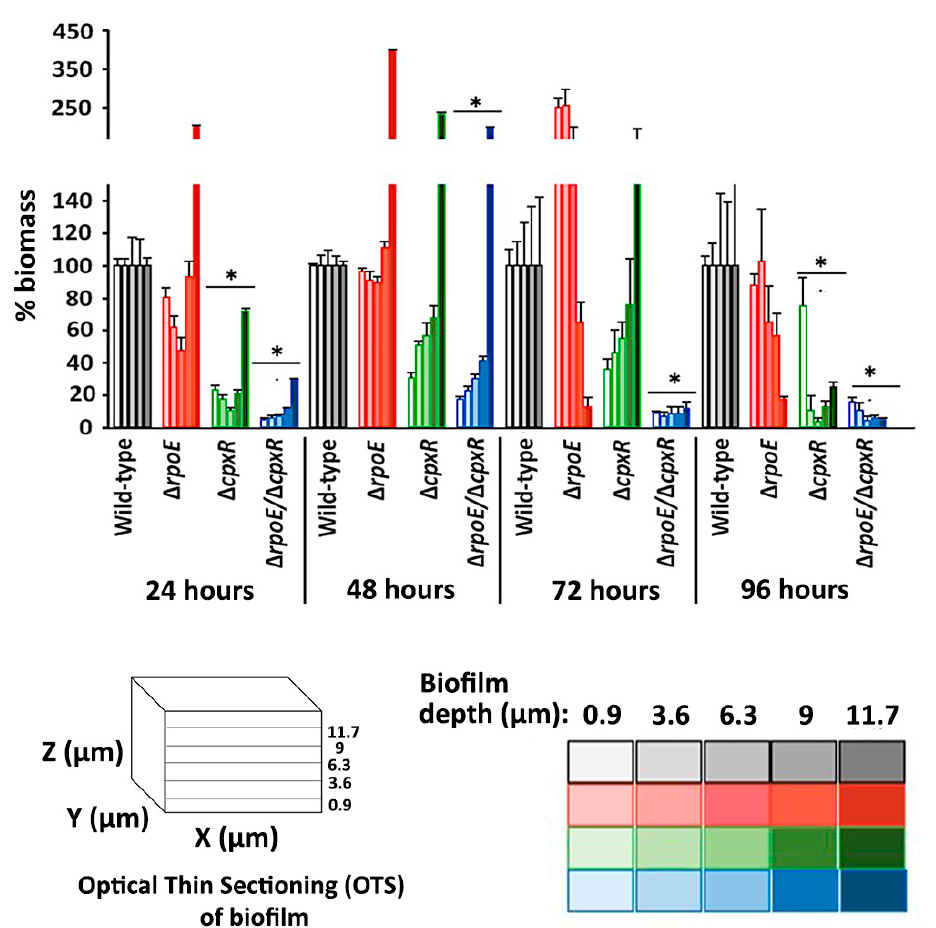
Figure 6. Effect of deletion of the rpoE, cpxR and rpoE/cpxR genes on the biofilm biomass, as measured by optical thin sectioning (OTS). Biomass of the wild-type, Δ rpoE , Δ cpxR and Δ rpoE / Δ cpxR biofilms was measured at 24 h intervals over the duration of the experiment (e.g., 96 h) under conditions reported above (Figure 5 legend). Each measurement was carried out at five OTS depths, including 0.9, 3.6, 6.3, 9 and 11.7 µm, where 0.9 µm sectioning depth represents the biofilm-substratum interface and the 11.7 depth µm represents that region closer to the biofilm-liquid interface (nearest to the center of the flow cell channel). The color-coded table indicates the percentage total biomass relative to the wild-type control biofilm at 0.9, 3.6, 6.3, 9 and 11.7 µm OTS depths, respectively. * p < 0.05.